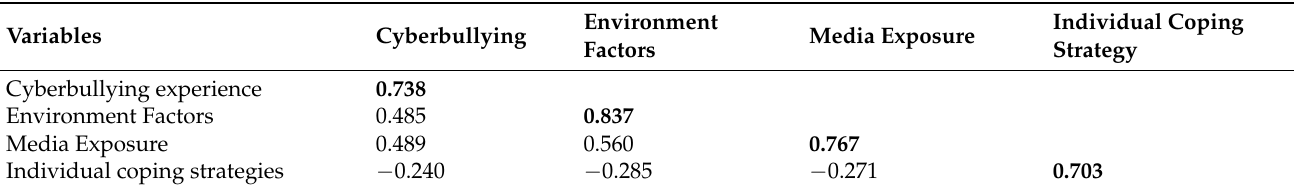
Table 3. Discriminant validity for second stage measurement model.